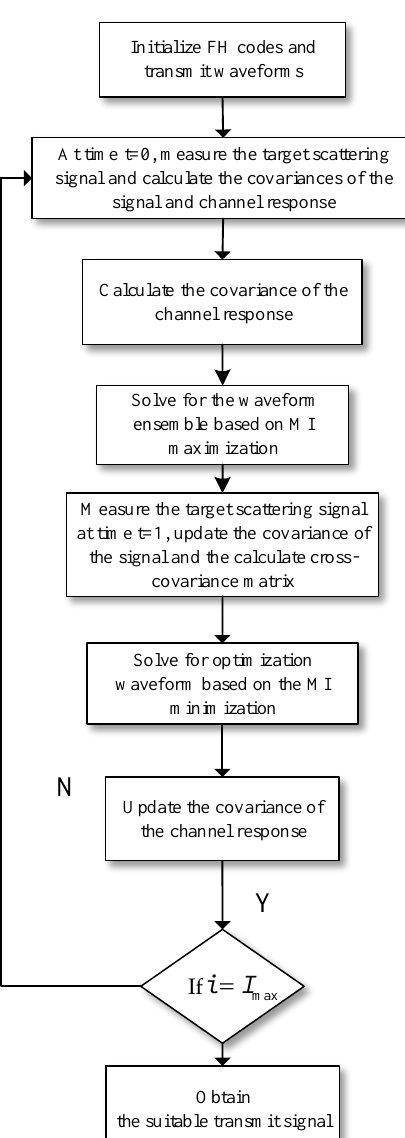
Figure 3. The adaptive waveform design and selection scheme for target detection.